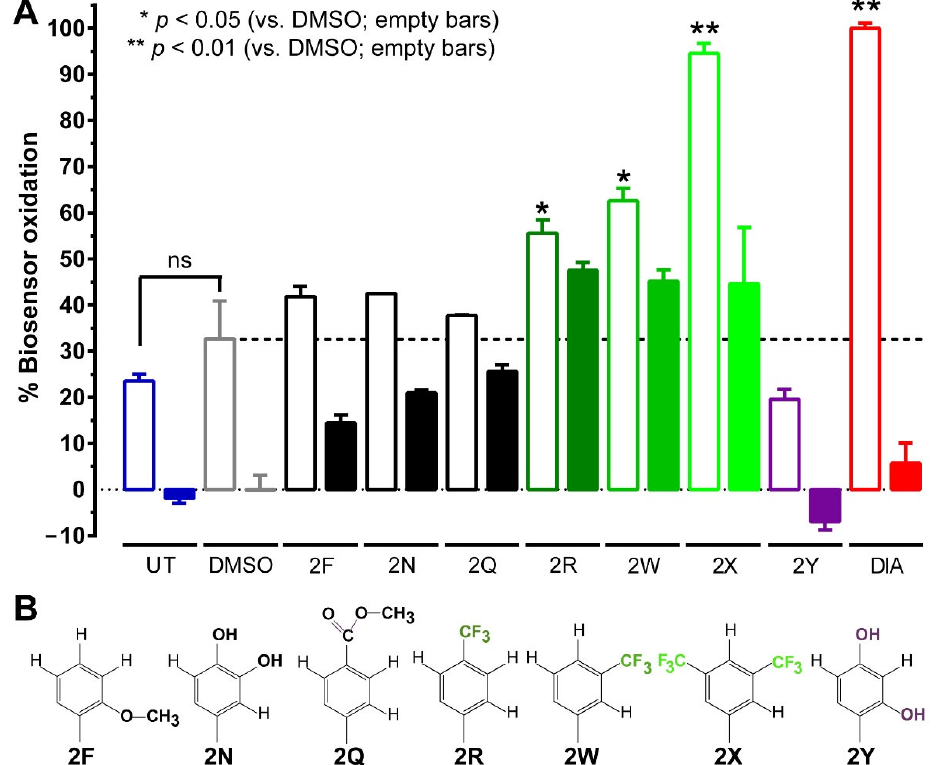
Figure 1. Intracellular thiol-redox perturbations produced by hit compounds in infective T. brucei : ( A ) Exponentially growing bloodstream T. b. brucei expressing the hGrx-roGFP2 biosensor was incubated for 1 h in the absence (UT—untreated) or presence of DMSO 1% v / v (DMSO) or hit compounds added at their corresponding IC 50 in DMSO 1% v / v (see Table 3). Treatment with diamide 250 µ M for 20 min was included as positive oxidation control (DIA). The solid bars correspond to samples subjected to the treatments described above and incubated for additional 20 min with DTT 1 mM as reducing control condition. The % biosensor oxidation is expressed relative to control conditions, inducing full biosensor oxidation (DIA) and reduction (DMSO + DTT). The dotted line denotes the cut-off value for the mean oxidation achieved in the DMSO sample. ns—not statistically significant ( p < 0.05). Further methodological details about the assay and analysis can be found